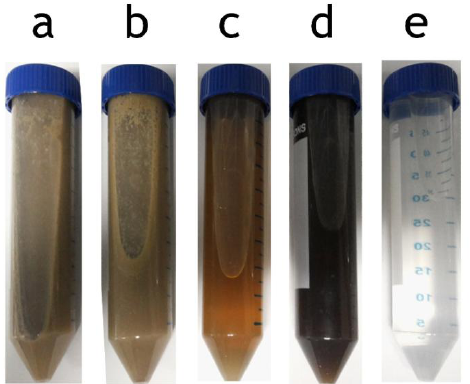
Figure 4. Water samples from MMF and MD of bovine stick water (BStW2): ( a ) stick water feed; ( b ) concentrate from MMF; ( c ) permeate from MMF (used as feed for MD); ( d ) concentrate from MD; ( e ) permeate from MD.